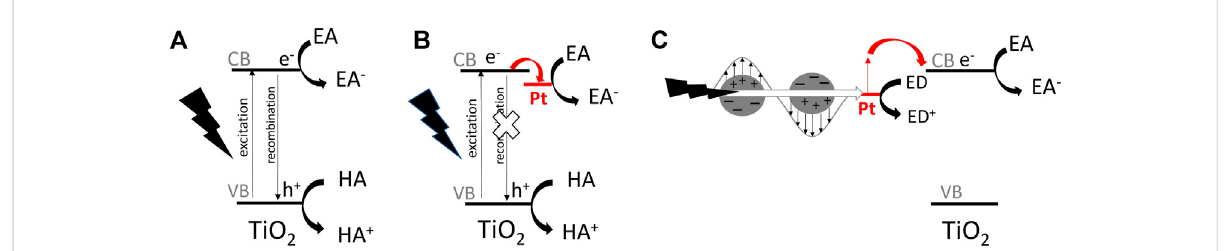
The schematic drawings of simpli fi ed mechanisms for photocatalytic reactions on titania-based photocatalyst: (A) pristine titania under UV excitation, (B) Pt-modi fi ed titania under UV excitation, (C) Pt-modi fi ed titania under vis excitation (considering an electron transfer mechanism); EA — electron acceptor, ED-electron donor, HA — hole